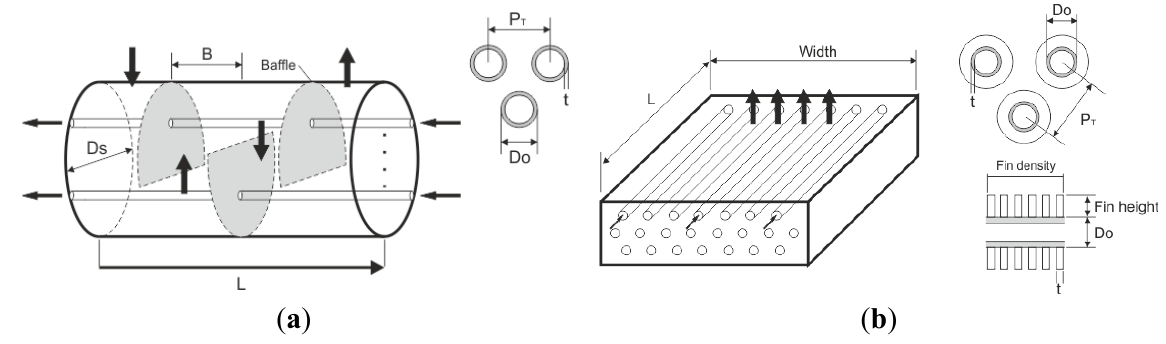
Figure 4. ( a ) Layout of shell/tube exchanger (evaporator and recuperator); ( b ) Layout of fin/tube exchanger cell (air-cooled